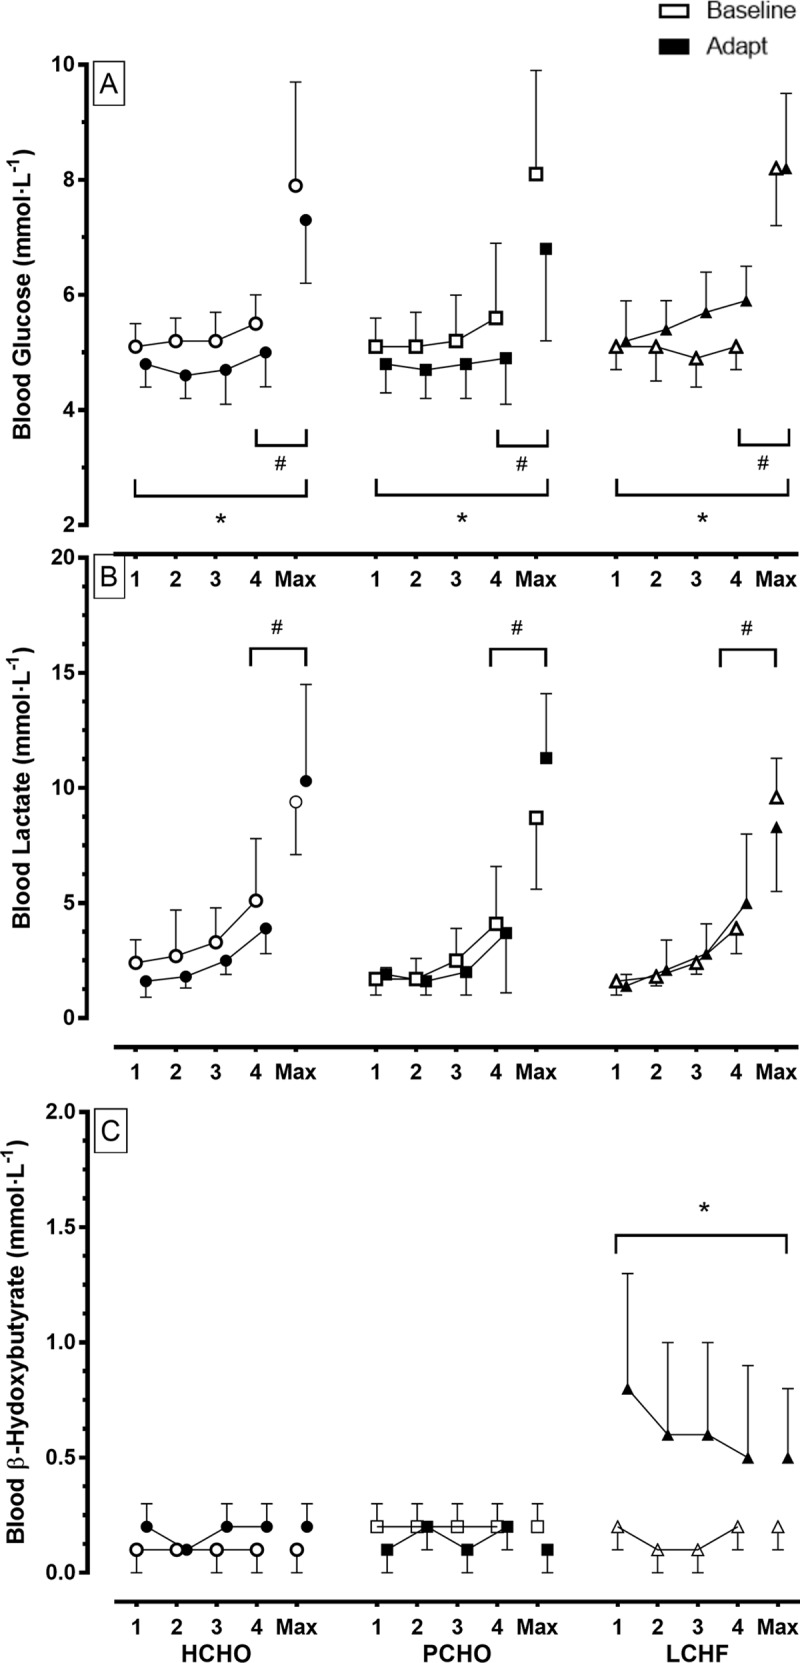
Blood metabolite concentrations [A: blood glucose (mmol∙L-1) B: blood lactate (mmol∙L-1) and C: blood ß-hydroxybutyrate (mmol∙L-1)] during graded economy test and test for peak aerobic capacity in elite race walkers pre- and post- 25 d of intensified training and high carbohydrate availability (HCHO, n = 8); periodised carbohydrate availability (PCHO, n = 8) or ketogenic low carbohydrate high fat (LCHF, n = 10) diets.* = significantly different to pre-treatment (p< 0.01).